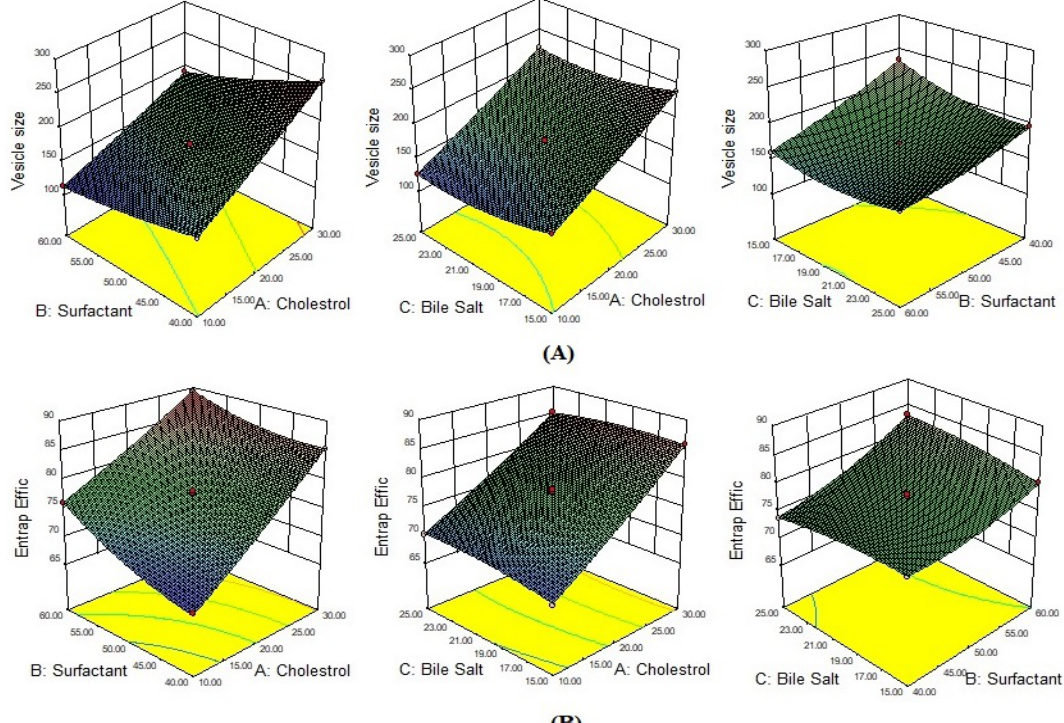
Figure 1. Effect of independent variables viz CHO, Span 60, and SDC on ( A ) Vesicle size, and ( B ) Entrapment efficiency.